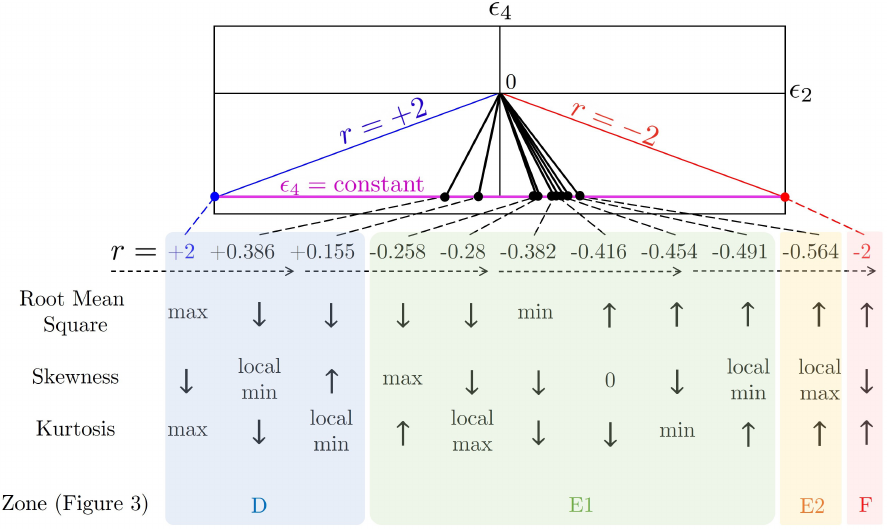
Figure 9. Summary of the parametric sensitivity of the key surface roughness metrics: root mean square, skewness, and kurtosis (Equations (17) and (18)). A straight line with slope 1/ ( 2 r ) passing through the origin in the parametric space ( (cid:101) 2 , (cid:101) 4 ) corresponds to a morphology (evaluated by C ( r ) -matrix), and its y -axis coordinate (purple line (cid:101) 4 = constant) determines the amplitude of the wrinkling profile. The location of these r -points in parametric space (Figure 3) are: r = − 2, zone F; r = − 0.564, zone E2; r = − 0.491 to − 0.258 are in zone E1; and r = + 0.155 to + 2 are in zone D. The density of the special surface roughness metrics in the negative r -value interval indicates that zone E1 in Figure 3 is a highly sensitive